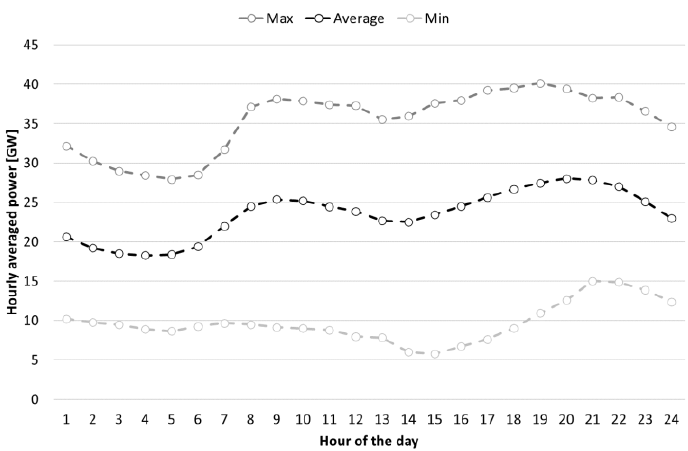
Figure 9. Hourly averaged power of non-renewable sources during the day in the reference year (2019); average, maximum and minimum values.